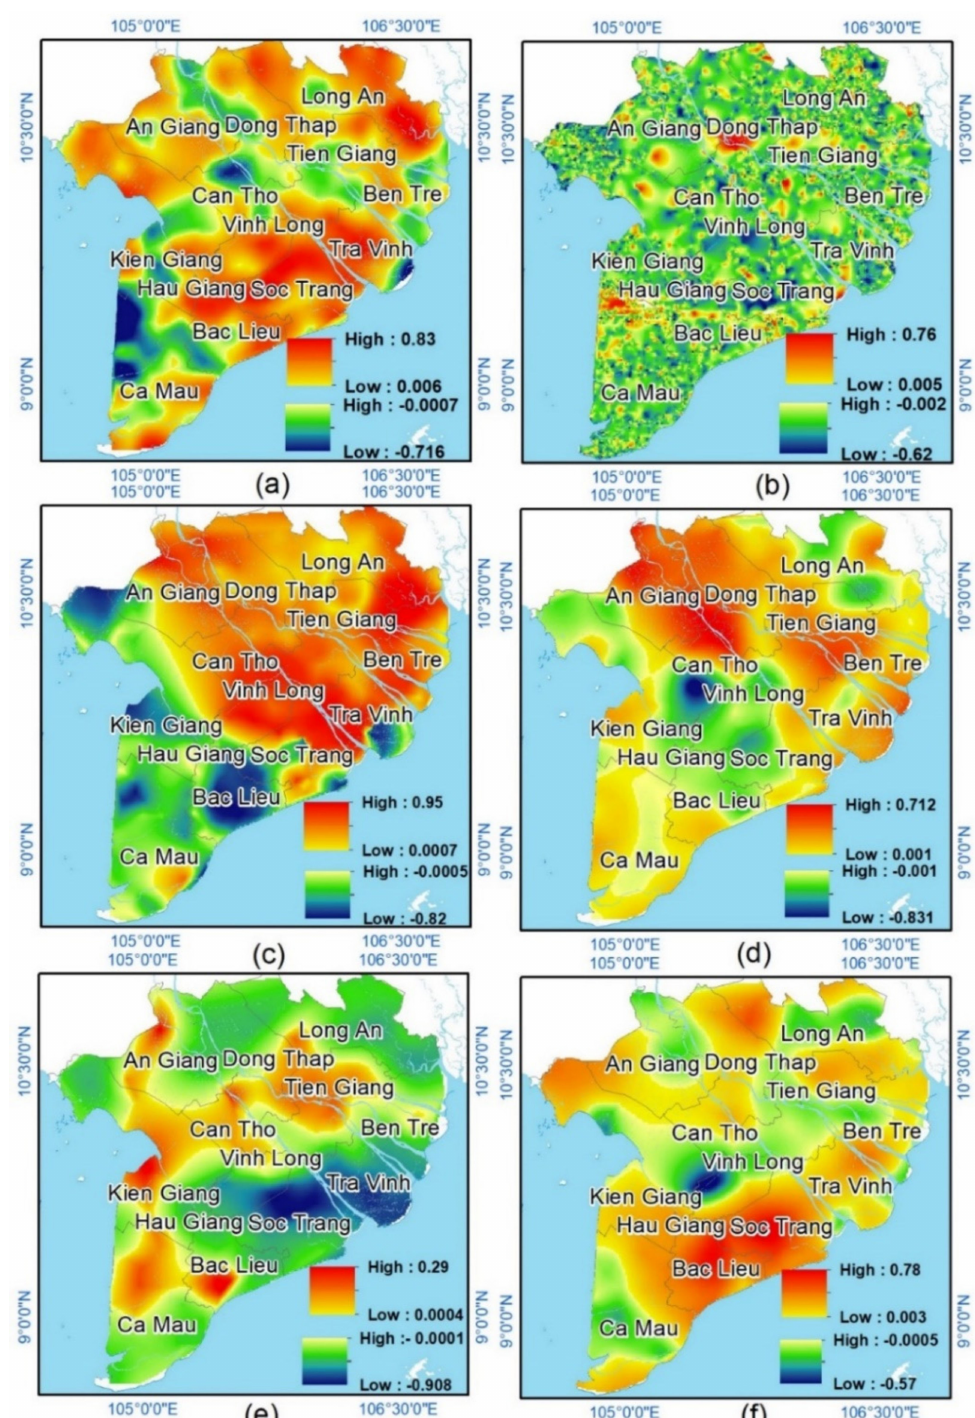
Figure 3. The GWR analysis between: ( a ) EVI and ET; ( b ) EVI and PET; ( c ) EVI and LST; ( d ) LST and ET; ( e ) LST and PET; ( f ) ET and PET local correlation coe ffi cients ( p < 0.01). These maps show both positive and negative spatial correlation between EVI, LST, and evapotranspiration. The negative correlation between LST and evapotranspiration is unusual compared to conclusions obtained in previous studies [30,33,40]. Several authors explored that PET or ET (which are measured from meteorological stations) are generally positively correlated to temperature (including water temperature and air temperature) [103–107]. However, some observations